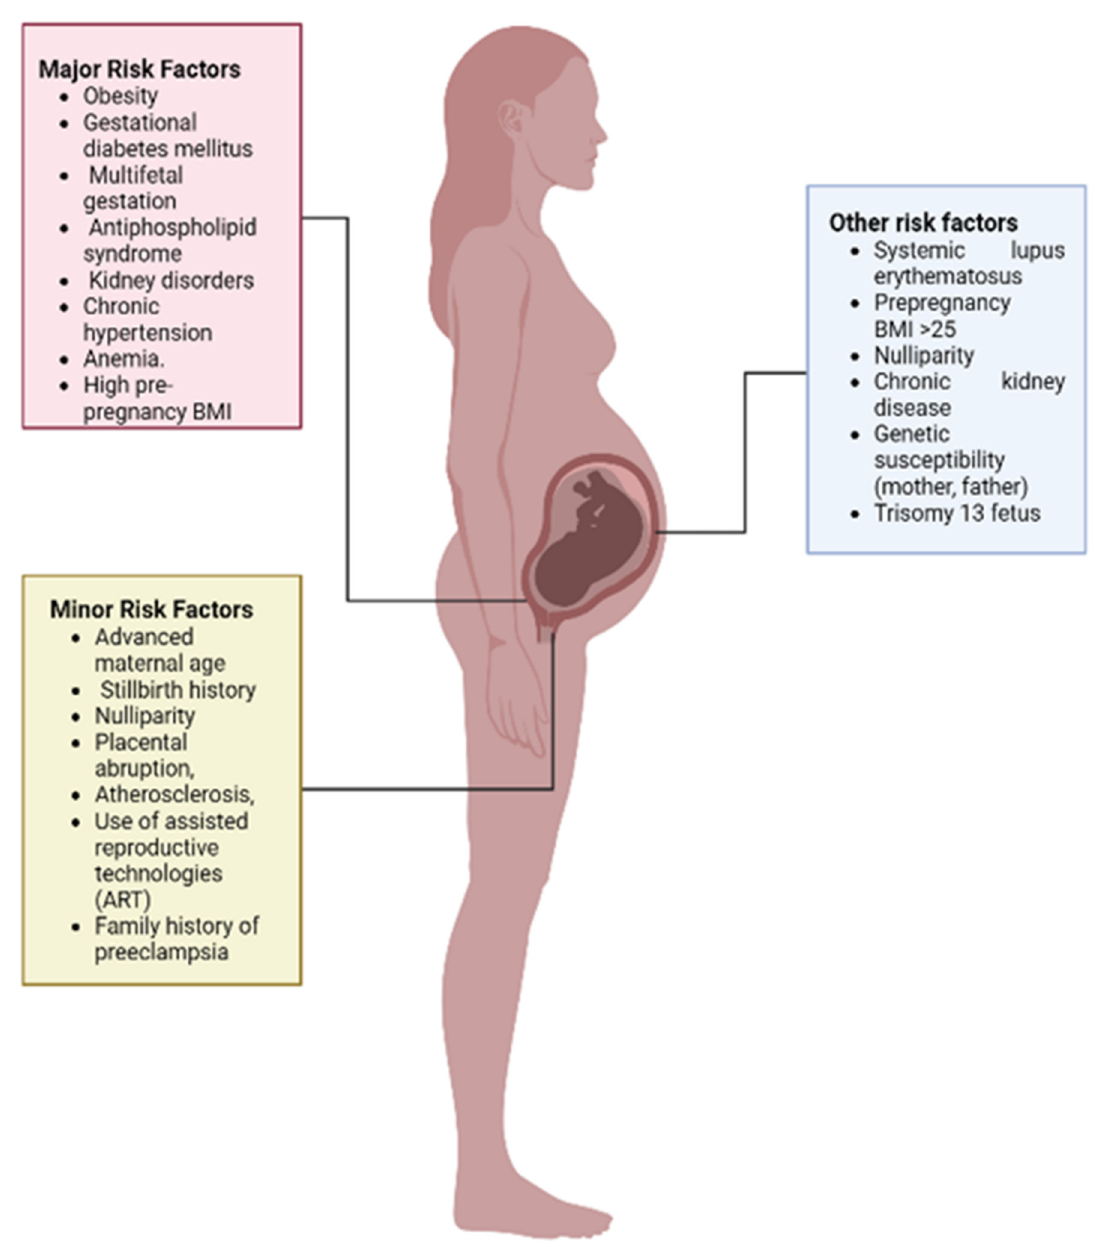
Figure 2. Risk factors of pre-eclampsia differentiated into major, minor, and others. Abbreviations | BMI, body mass index; ART, assisted reproductive technologies.